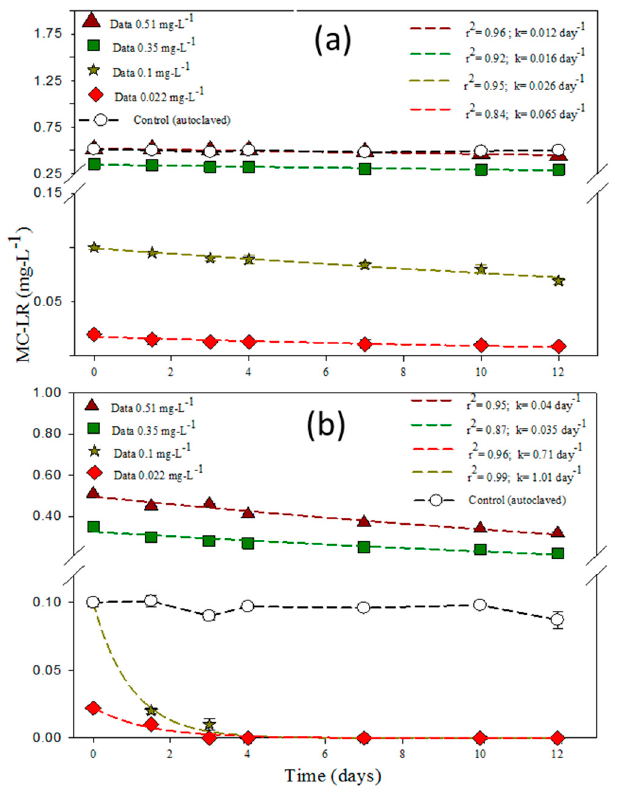
Figure 6. ( a ) MC ‐ LR degradation under Bacillus sp. 8.3 × 10 6 CFU/mL at four different concentrations ( a ) MC-LR degradation under Bacillus sp. 8.3 × 10 6 CFU/mL at four different of MC ‐ LR at 25 °C; ( b ) MC ‐ LR degradation under Bacillus sp. 8.1 × 10 10 CFU/mL at four different concentrations of MC-LR at 25 ◦ C; ( b ) MC-LR degradation under Bacillus sp. 8.1 × 10 10 CFU/mL at concentrations of MC ‐ LR at 25 °C. The error bars represent one standard deviation for three measurements. four different concentrations of MC-LR at 25 ◦ C. The error bars represent one standard deviation for three